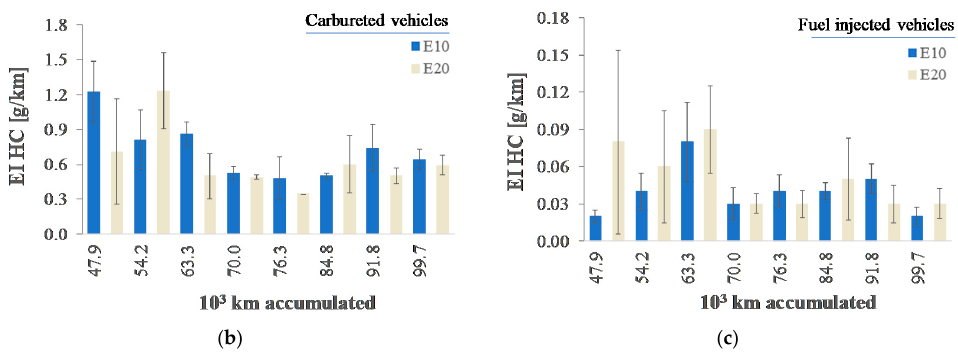
Figure 8. HC emission indexes obtained from ( a ) Our analytical model for engines; ( b ) Carbureted and ( c ) Fuel-injected vehicles following the NEDC on a chassis dynamometer every 10,000 km of operation .